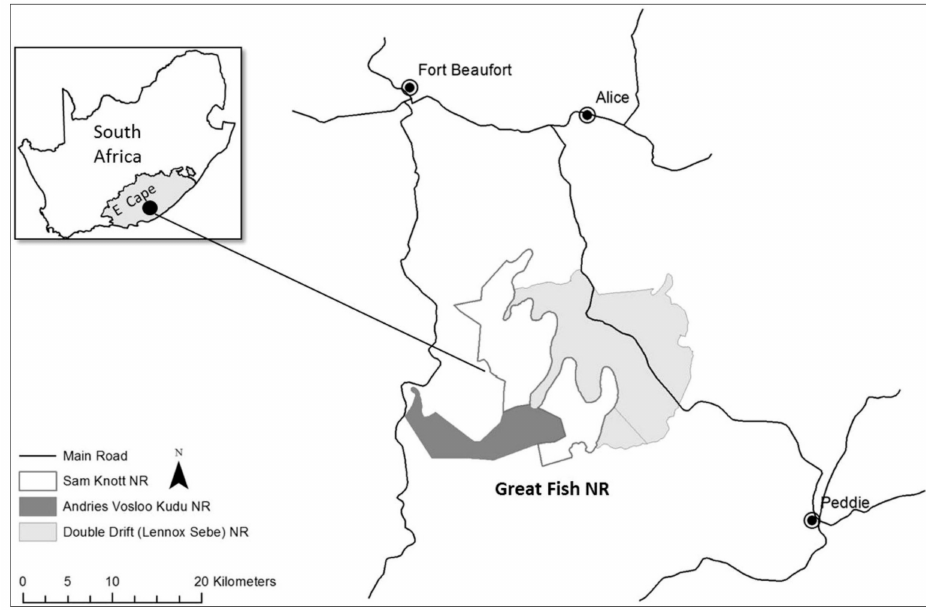
Figure 1. Location of case study one: the Great Fish Nature Reserve and the Likhayalethu community